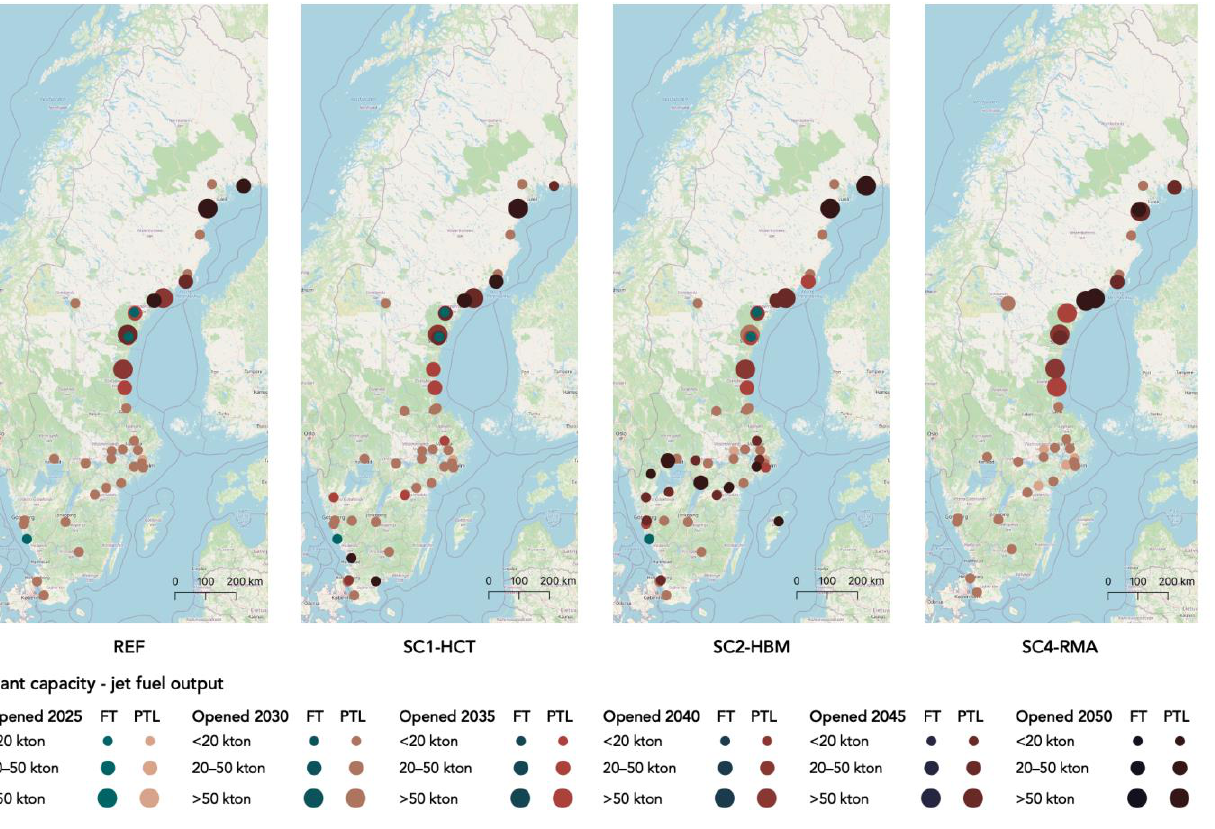
Figure 9. Optimal RJF production sites from all scenarios. REF (Reference scenario); SC1-HCT (Higher carbon tax); SC2-HBM (Higher blending mandate); SC4-RMA (High/Low raw material availability). FT (Fischer–Tropsch); HTL (Hydrothermal liquefaction); PTL (Power-to-liquid); CJF (Conventional jet fuel); HEFA (Hydroprocessed esters and fatty acids). Base map data © OpenStreetMap contributors, available under the Open Database License, terms further described in [106].